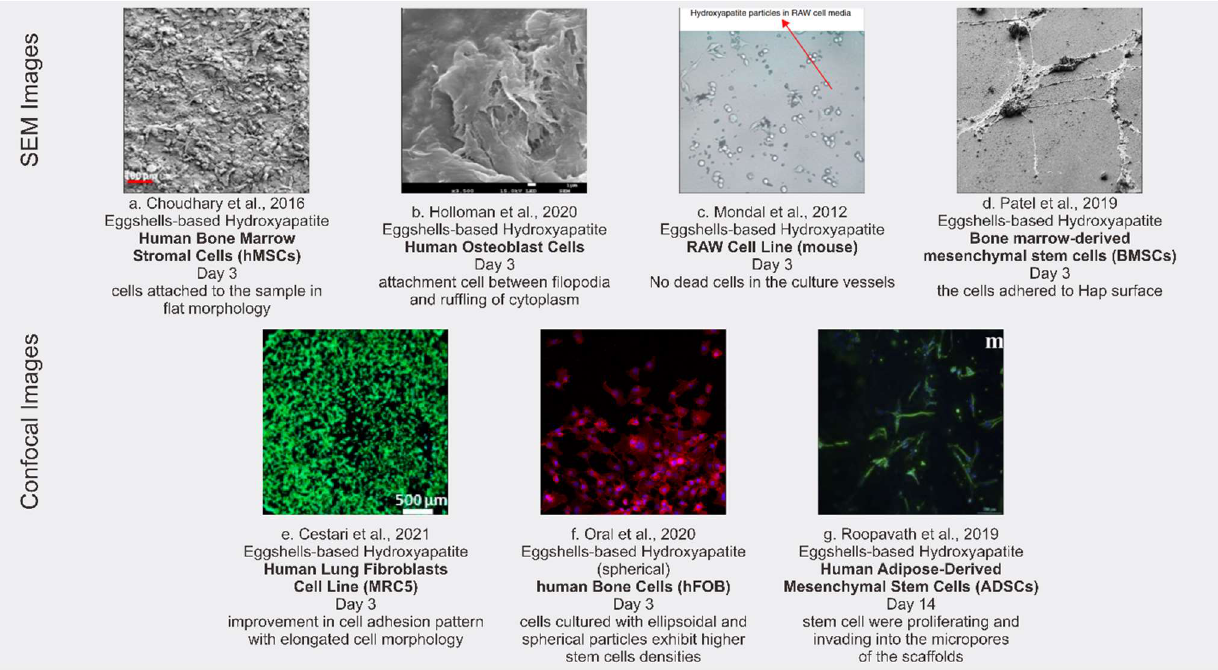
Figure 3. SEM images ( a – d ) and confocal images ( e – g ) of cytotoxicity tests with different stem cells for cultures.